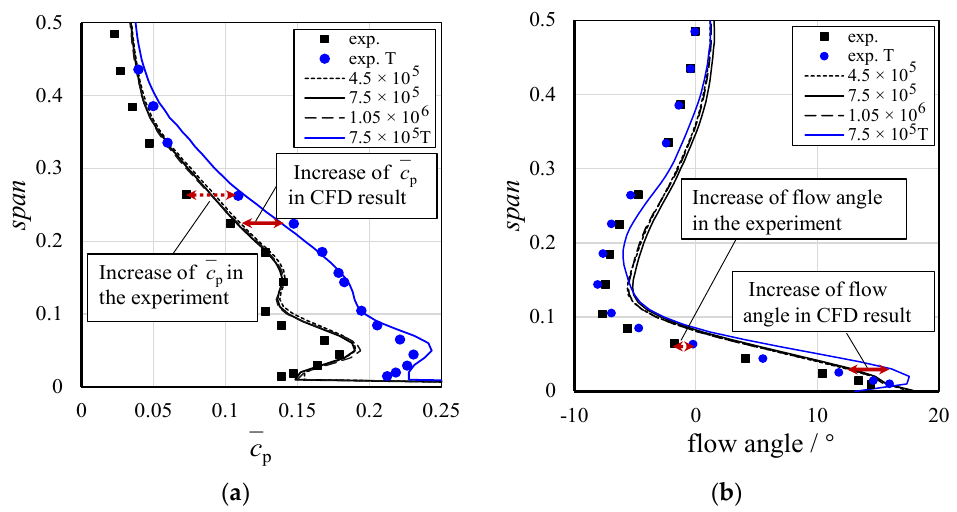
Figure 5. The pitch-averaged performance at 40% C a downstream of the TE at i = −1°. ( a ) Total pressure loss coefficient; ( b ) outflow angle.